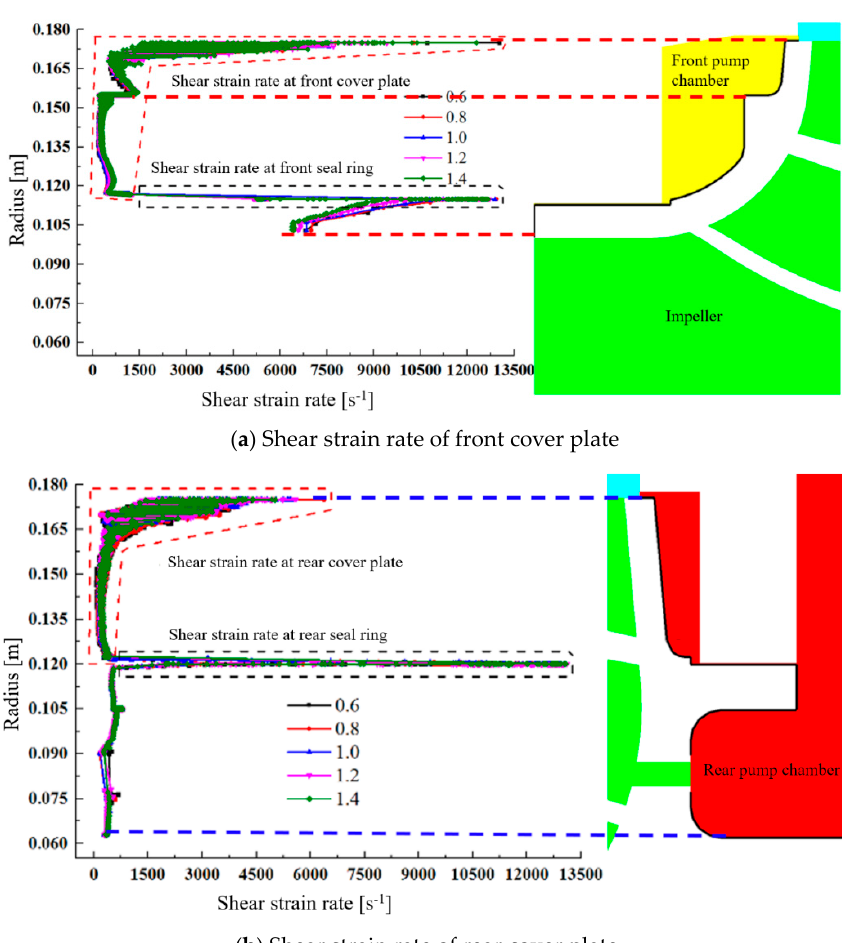
Figure 13. Shear strain rate distribution of cover plate.